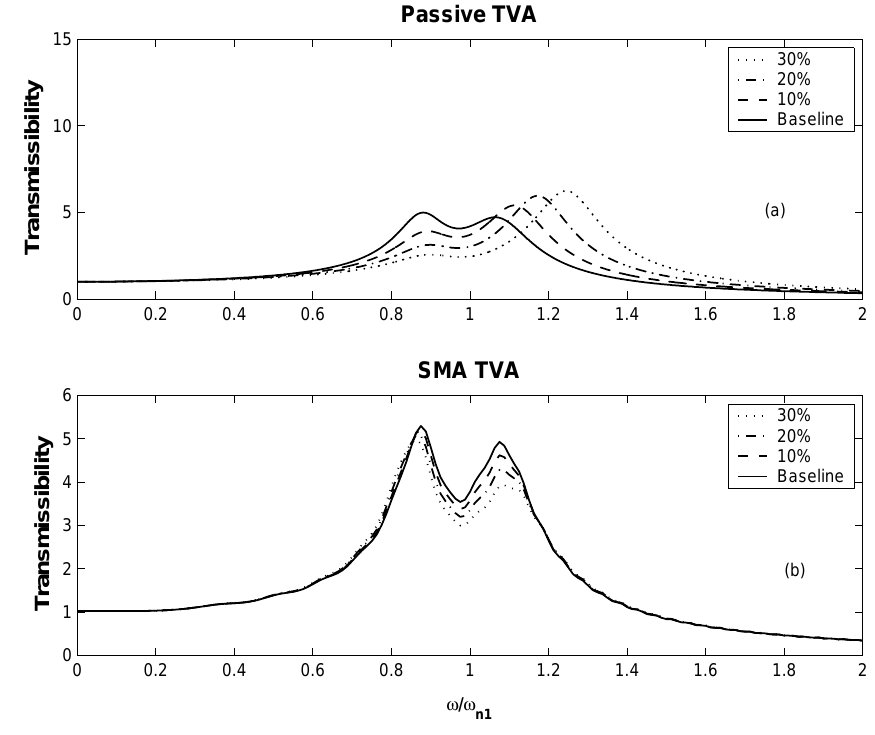
Fig. 10. Peak transmissibility variation, reducing the primary mass by 30%: (a) passive TVA (b) SMA